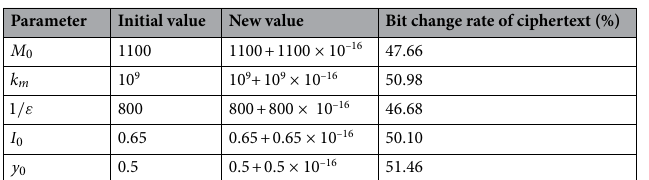
Table 1. Bit change rate of ciphertext with the change of